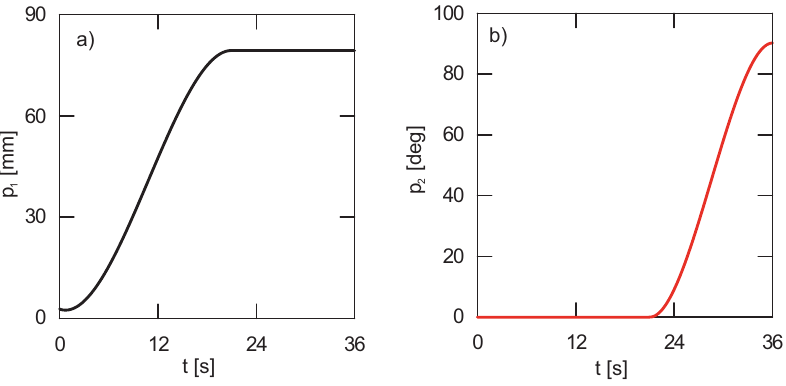
Figure 6. Kinematic forcing—( a ) inclination angle actuator, ( b ) platform